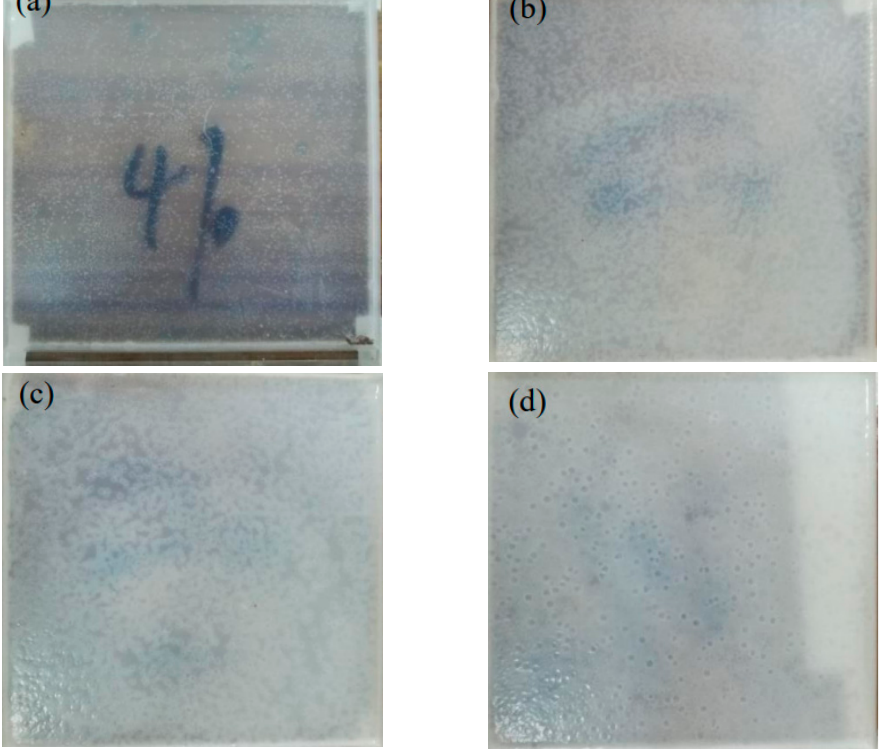
Figure 3. W-OH solid consolidations with different concentrations: ( a ) W-OH concentration: 4%; ( b ) W-OH concentration: 6%; ( c ) W-OH concentration: 8%; and ( d ) W-OH concentration: 10%.